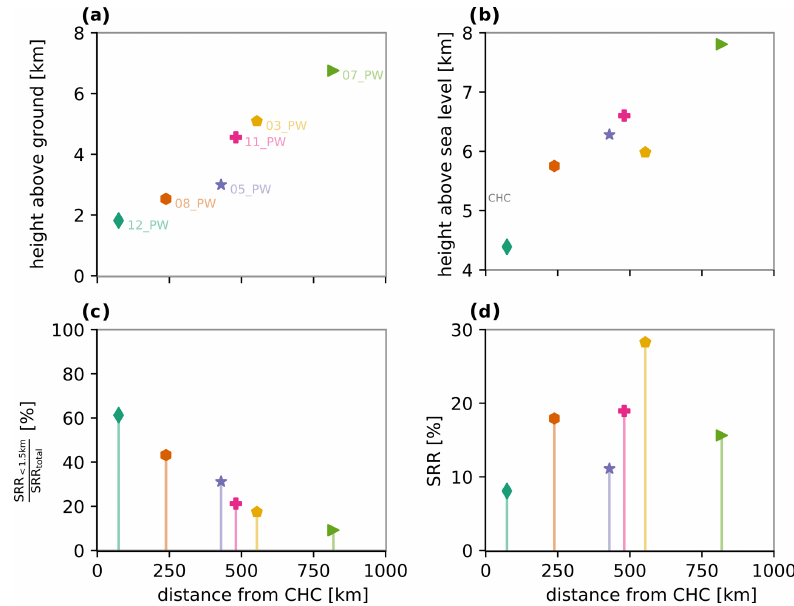
Figure 7. Centroid properties for each of the main PWs. Panel (a) shows the median height above ground level of each cluster, while (b) shows the median height above sea level. Panel (c) shows the ratio between the SRR values that are below 1.5km above ground level and the total SRR value for each cluster. Panel (d) shows the mean SRR percentage for each PW. Quantitative numbers are presented in Fig. S2.